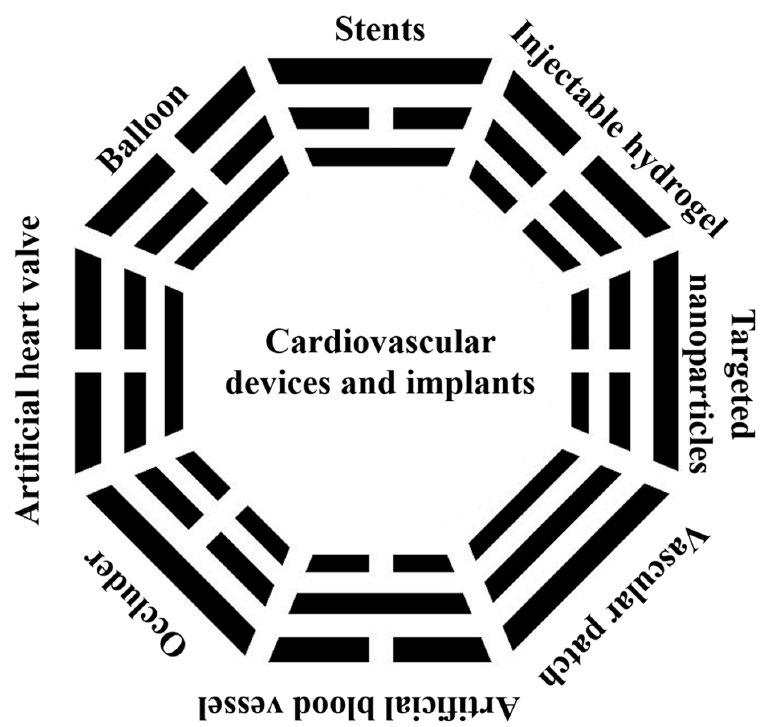
Figure 1. The Chinese eight diagrams to describe the types of artificial cardiovascular devices and implants. and